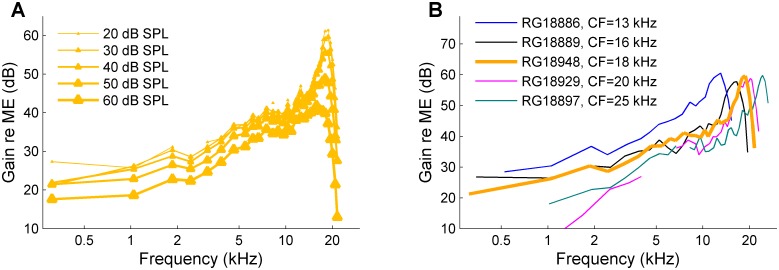
Sensitivity of the cochleae.(A) a set of responses to a wideband zwuis stimuli at multiple SPLs as indicated in the graph, recorded from the CF = 18 kHz cochlea of Figure 4. The curves display the familiar compressive behavior of sensitive cochleae. (B) 30-dB-SPL recordings obtained from all five cochleae displayed in Figure 4, using the same colors as in that figure.